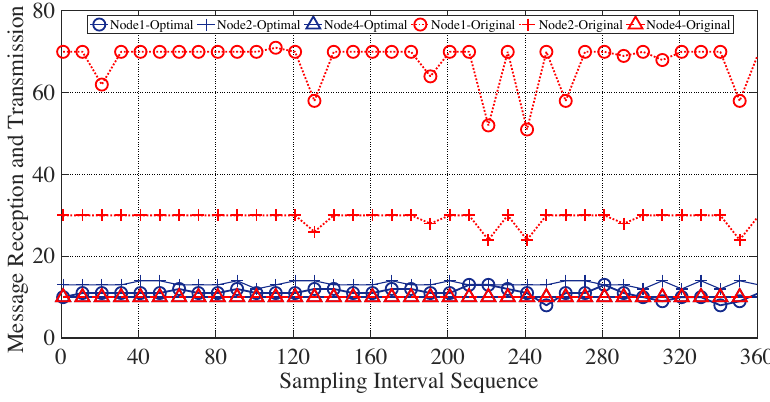
Figure 11. Number of message receptions and transmissions of sensor nodes with and without optimal message bundling for 3600s with sampling interval of